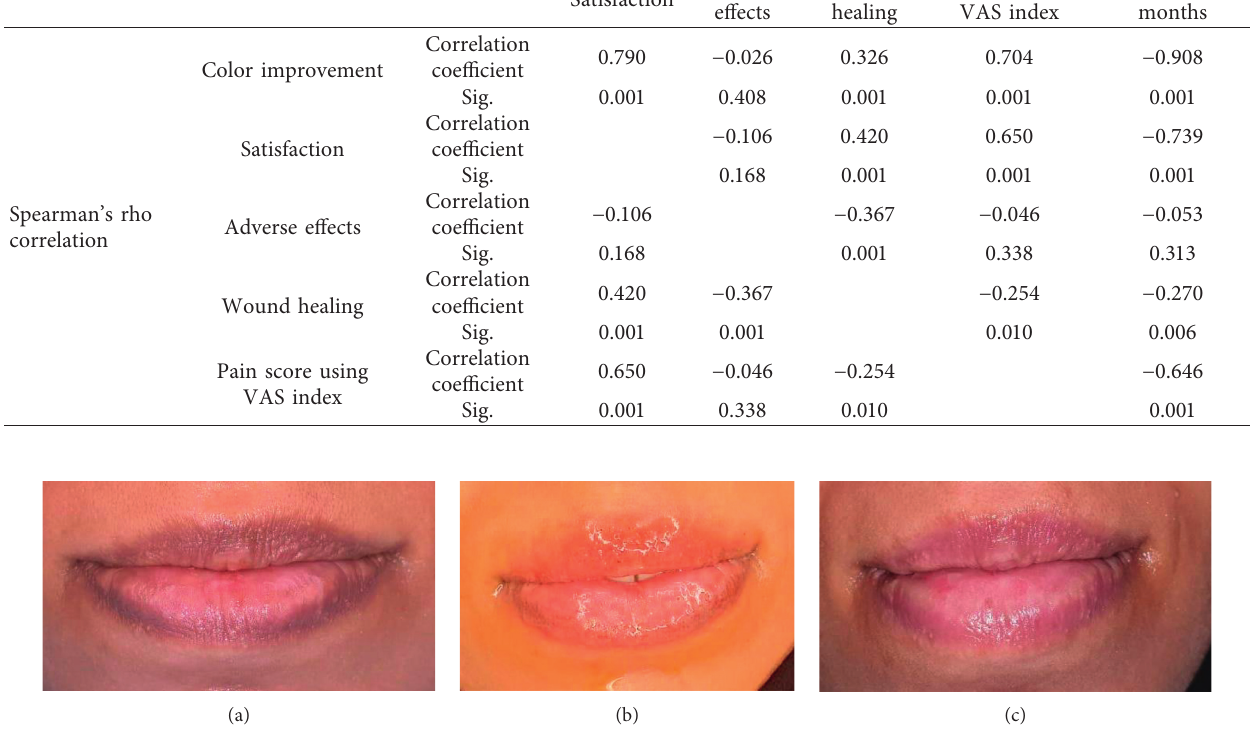
Figure 10: (a) Before, (b) mild swelling after the session, and (c) after complete